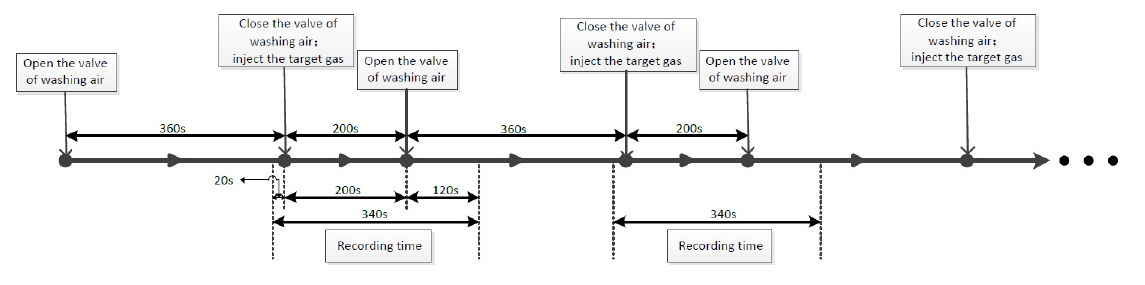
Figure 2. The procedure of